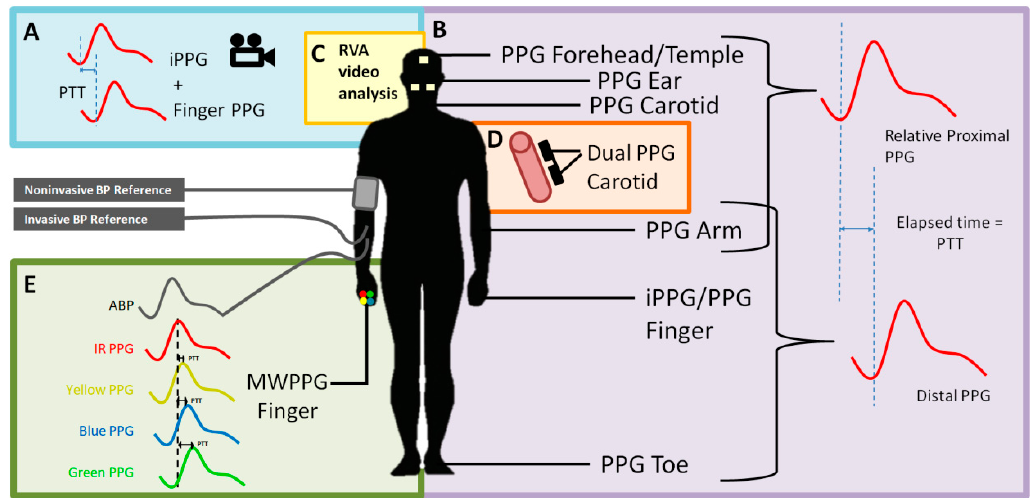
Figure 1. A visualization of the methods multi-site photoplethysmography (PPG) to measure the pulse transit time (PTT). Multisite PPG can make use of twos PPG probes, one proximal and one distal, to measure the time it takes for the pulse wave to travel a distance. ( A , B ) Two-location dual PPG/iPPG systems. ( C ) iPPG system. ( D ) Single artery dual PPG system. ( E ) Multiple wavelengths system.